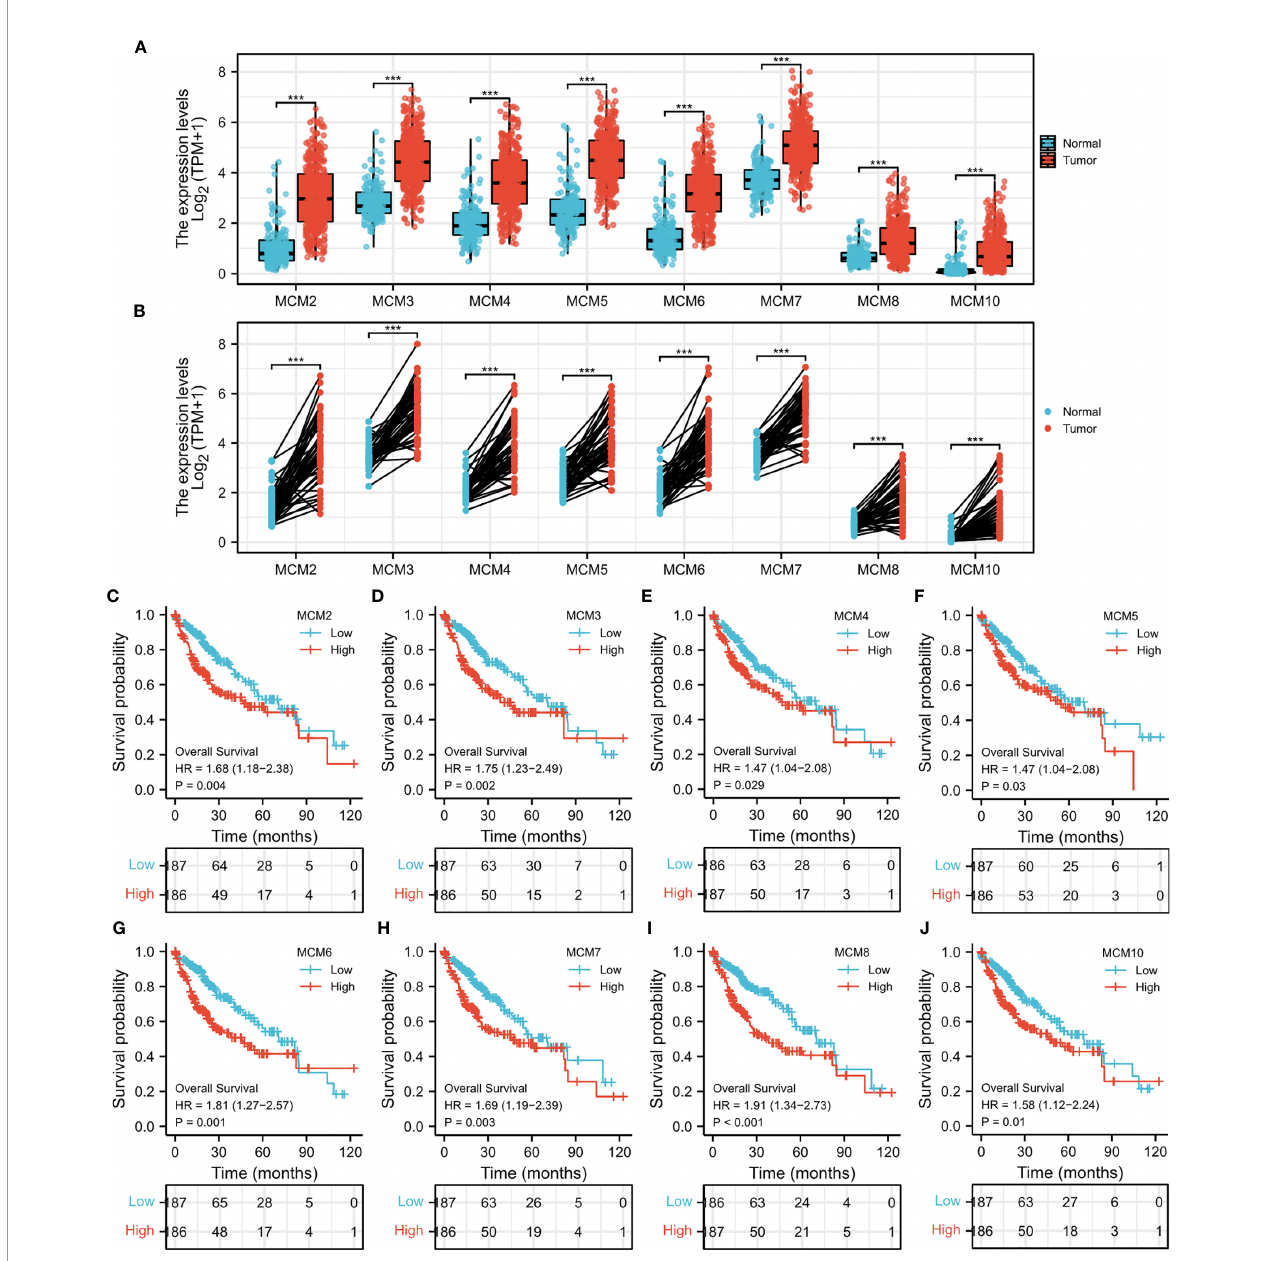
FIGURE 9 | (A) mRNA expression levels of all MCM family genes in HCC tissues and normal tissues. (B) The expression of MCM family members in paired HCC tissues. (C – J) Survival analysis of MCMs in HCC. *** p <